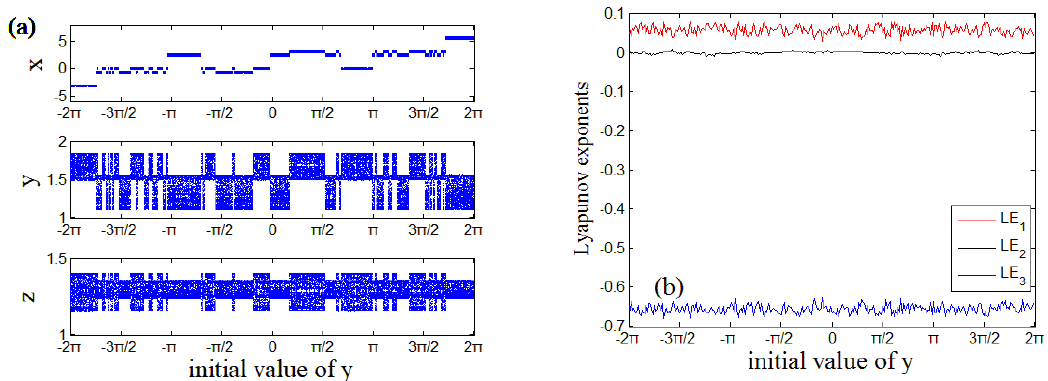
Figure 8. ( a ) Bifurcation diagram and ( b ) Lyapunov exponent spectra versus initial value y 0 , when a = 1.5, b = 0.6, c = 1.0, d = 2, x 0 = 0.1, z 0 = 0.1.